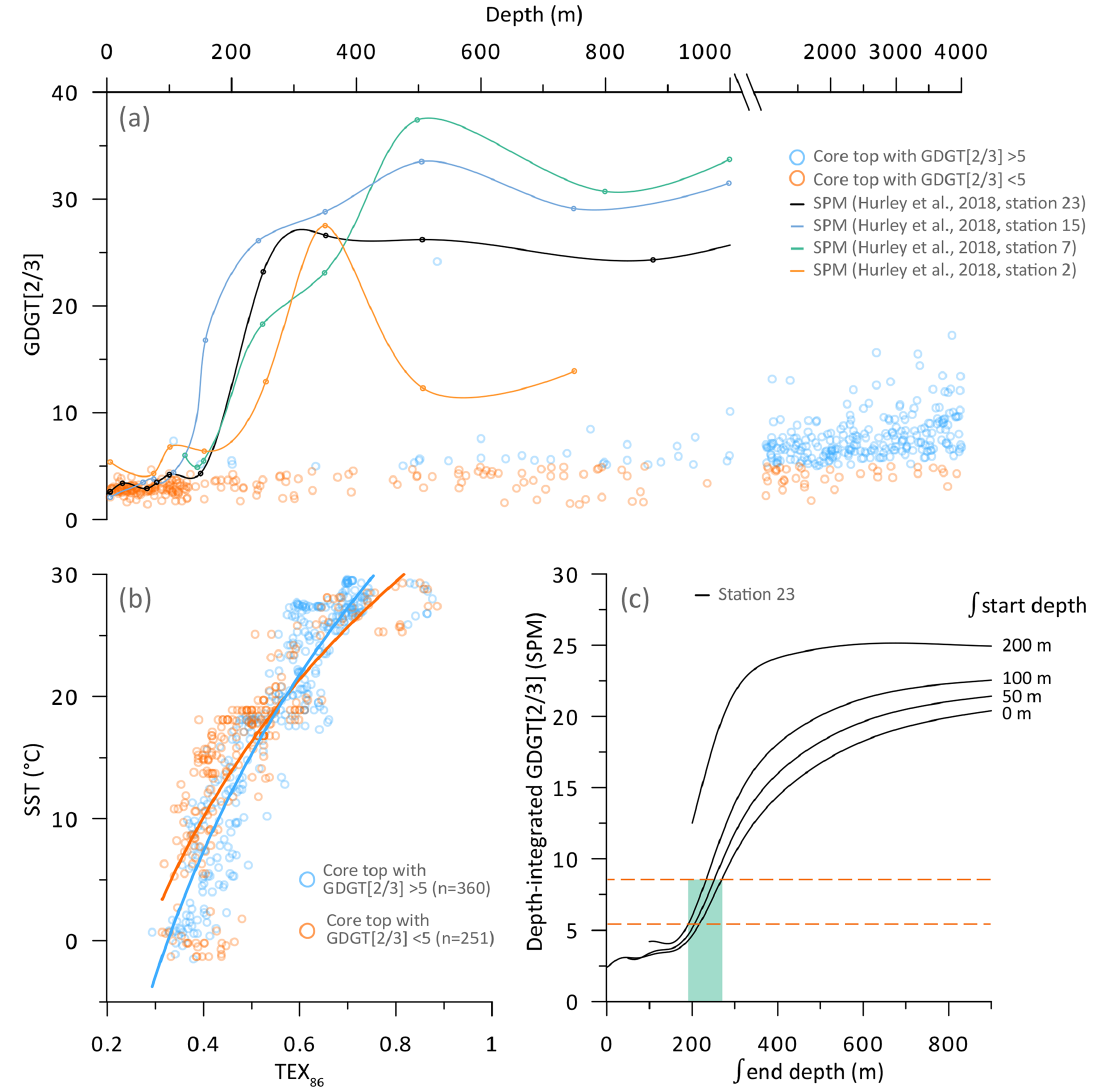
Figure 1. (a) Depth distribution of GDGT [ 2 / 3 ] ratio in suspended particulate matter (SPM; solid lines) at several stations in the Atlantic Ocean (Hurley et al., 2018) and in core tops (circles) between 65 ◦ N and 65 ◦ S (Tierney and Tingley, 2015). (b) GDGT [ 2 / 3 ] vs. TEX 86 , with logarithmic fits for GDGT [ 2 / 3 ] > 5 (blue line) and GDGT [ 2 / 3 ] < 5 (orange line). (c) Depth-integrated (linear) GDGT [ 2 / 3 ] from SPM data (station 23; Hurley et al., 2018). Integration start depths at 0, 50, 100 and 200m and continuous end depth on the x axis. Range of typical Site 959 sedimentary GDGT [ 2 / 3 ] values between orange dashed lines and corresponding range of potential integration end depths in the vertical. Note that the assumed linear depth weighing may not be realistic but that an integration start depth at 200m is incompatible with the sedimentary GDGT [ 2 / 3 ] values at Site 959, regardless of depth